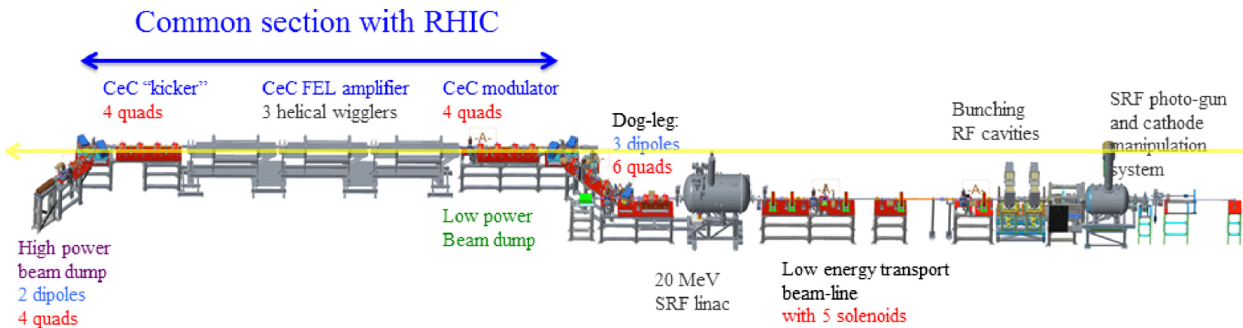
FIG. 2. The CeC system at BNL. It includes the following equipment: 112 MHz SRF gun; 500 MHz RF buncher/pre-accelerator; 20 MeV 704 MHz SRF module; electron beam transport magnets (dipoles, quadrupoles, solenoids, trims); helical FEL wigglers; beam dump; and RHIC DX-, D0-, and triplet-magnets. The electron beam is merged with the ion beam using an achromatic dog-leg, cools the ions in the CeC, and then is discarded into a